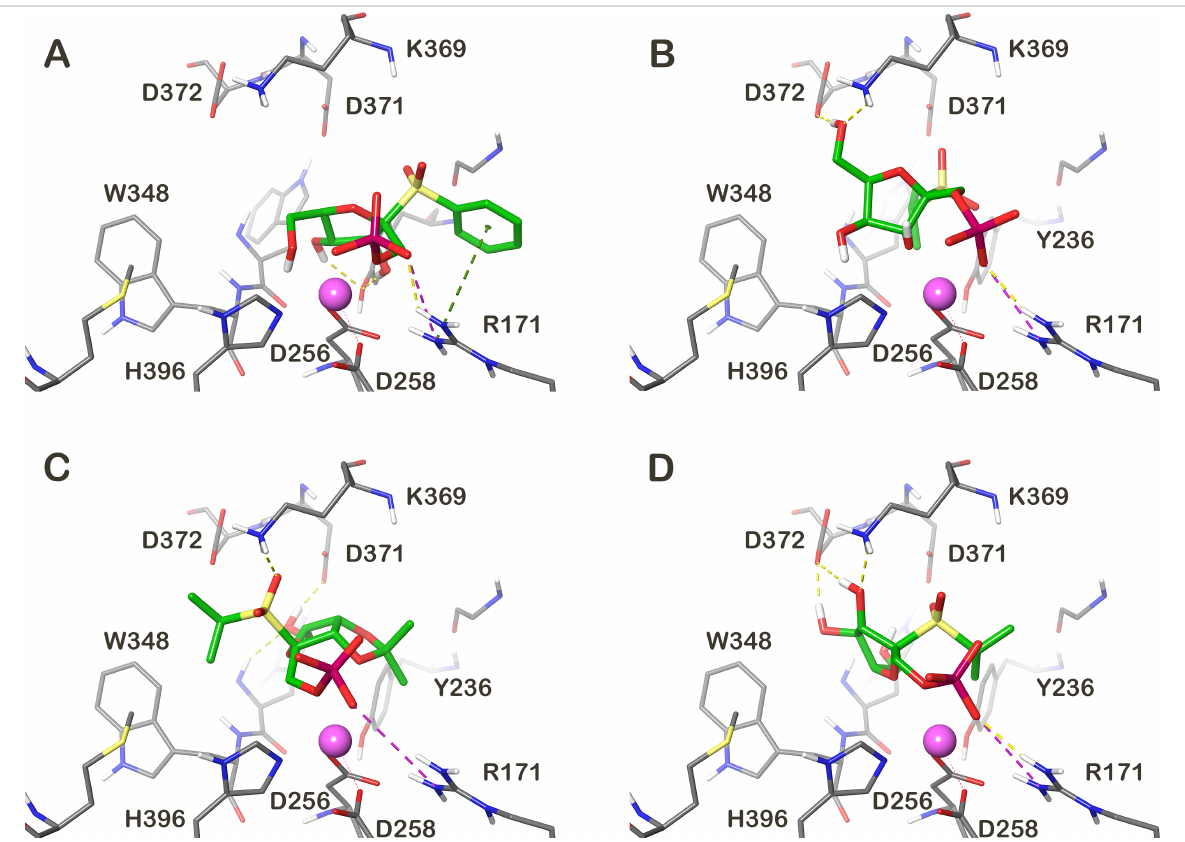
Figure 2: Molecular representation of the best binding poses of the four compounds with the predicted highest affinity. (A) 1b α , (B) 2c , (C) 3c and (D) 1c β . The molecule–GlfT2 interactions are depicted as dashed lines (yellow – hydrogen bonds, magenta – salt bridge, green – cation/ π interaction). The Mg 2+ ion is shown as a purple